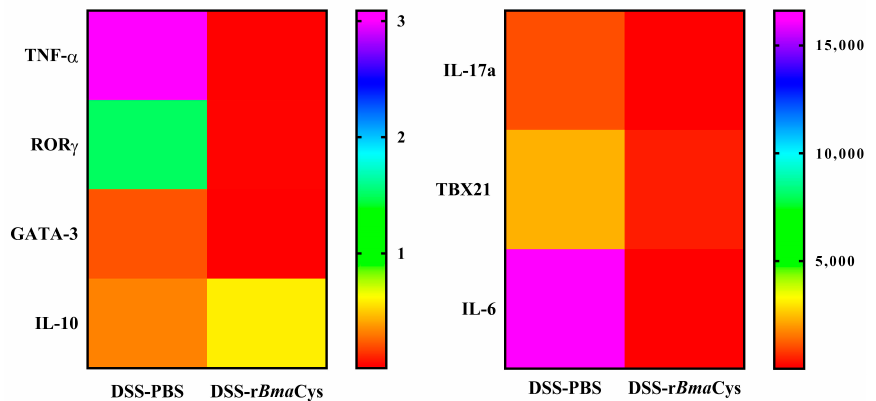
Figure 2. Expression of inflammatory genes and transcription factors was downregulated in DSS-r Bma Cys-treated mice. Colon tissues from mice were processed for RNA isolation followed by cDNA synthesis and TaqMan qPCR analysis. Relative gene expression is represented as a heat map. The results show downregulation in the expression of TNF- α , ROR γ , GATA-3, IL-17a, TBX21, and IL-6 genes in the DSS-r Bma Cys-treated mice compared to the DSS-PBS group ( n = 2; colon samples from male mice and female mice were pooled separately within each group to recover more cells for the analysis). Significance within the groups was determined using one-way ANOVA followed by Tukey’s posthoc